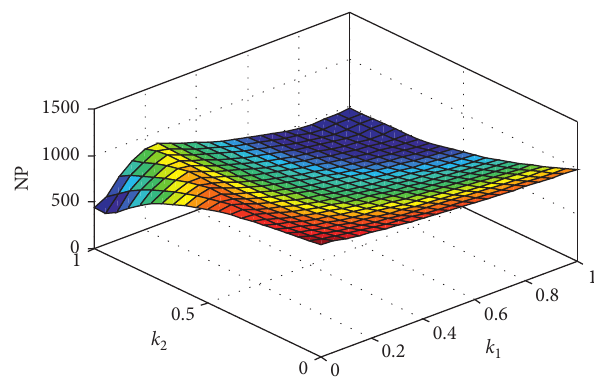
Figure 5: Relationship between the total project optimization profit NP and fairness concern behavior of both